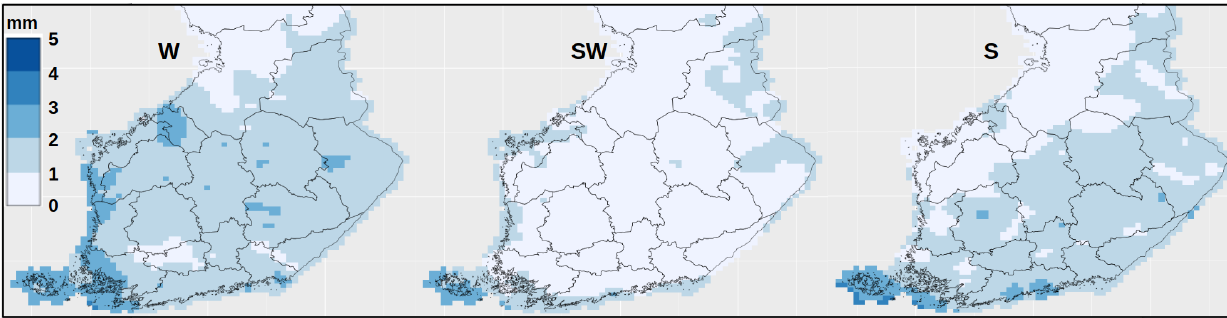
Figure 6. Average daily precipitation amount (mmd − 1 ) from FMIClimGrid data during 2000–2010 whenever there were favorable con- ditions to bring sea-effect snowfall towards coast in W, SW and S areas (as in Fig. 4a–c). The average daily precipitation was calculated without the event on 30 November 2005 (Sect.